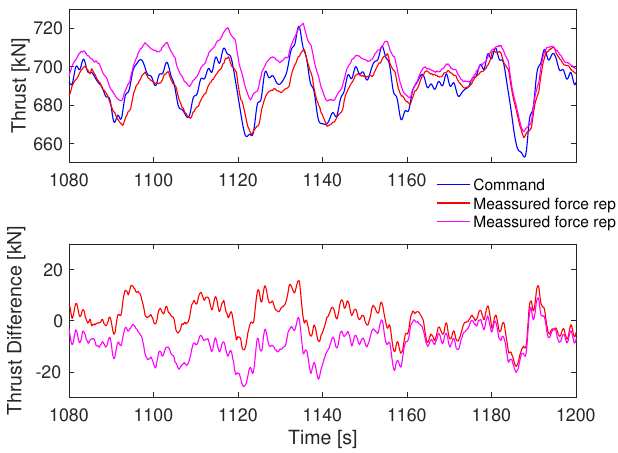
Figure 7. Time domain response of wind thrust actuator.